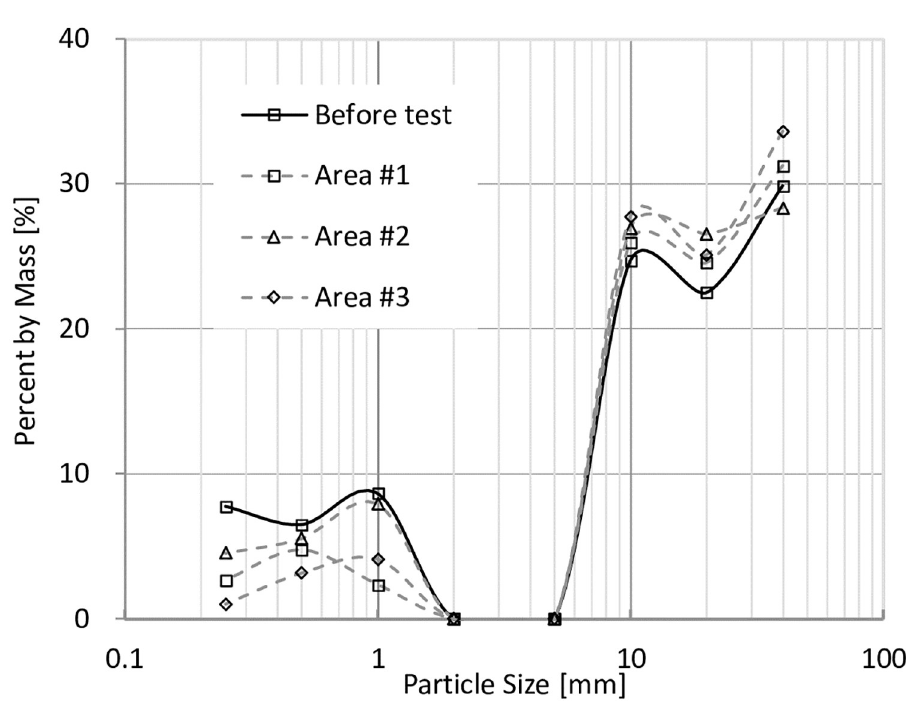
Fig 15. Frequency of particles with different sizes in each area of the model with VFR = 60%.